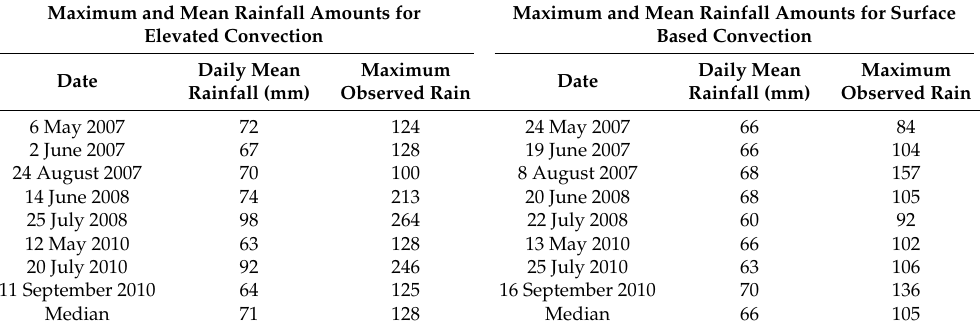
Table 6. Maximum and mean rainfall amounts for elevated convection events (left) and surface based convection events